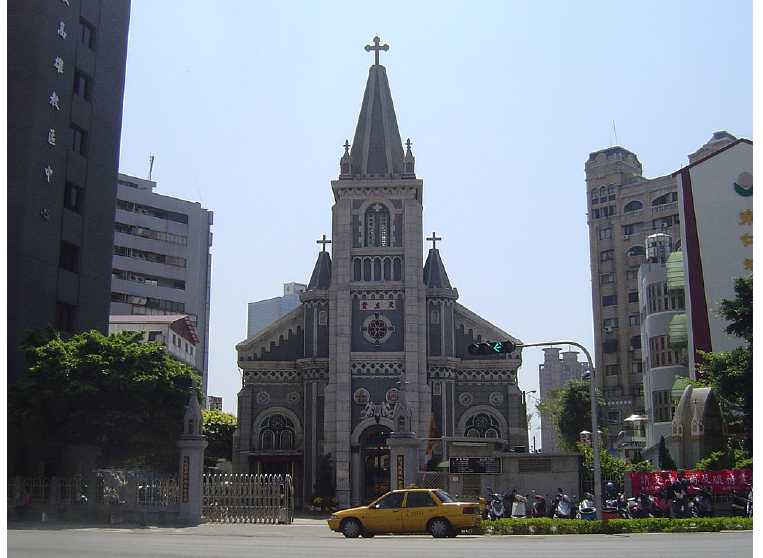
Figure 5. The Holy Rosary Cathedral 玫 瑰 聖 母 聖 殿 主 教 座 堂 is the oldest Catholic church in Taiwan, located in Lingya District, Kaohsiung, just east of the Love